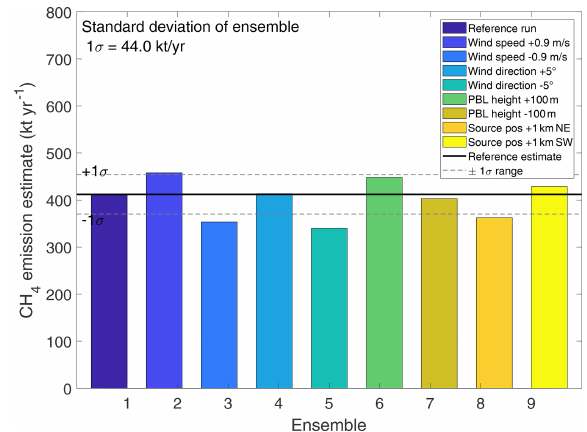
Figure 12. A posteriori correlation matrix as deduced from the a posteriori covariance matrix showing there remained some uncer- tainty regarding to which shaft the emissions had to be assigned.